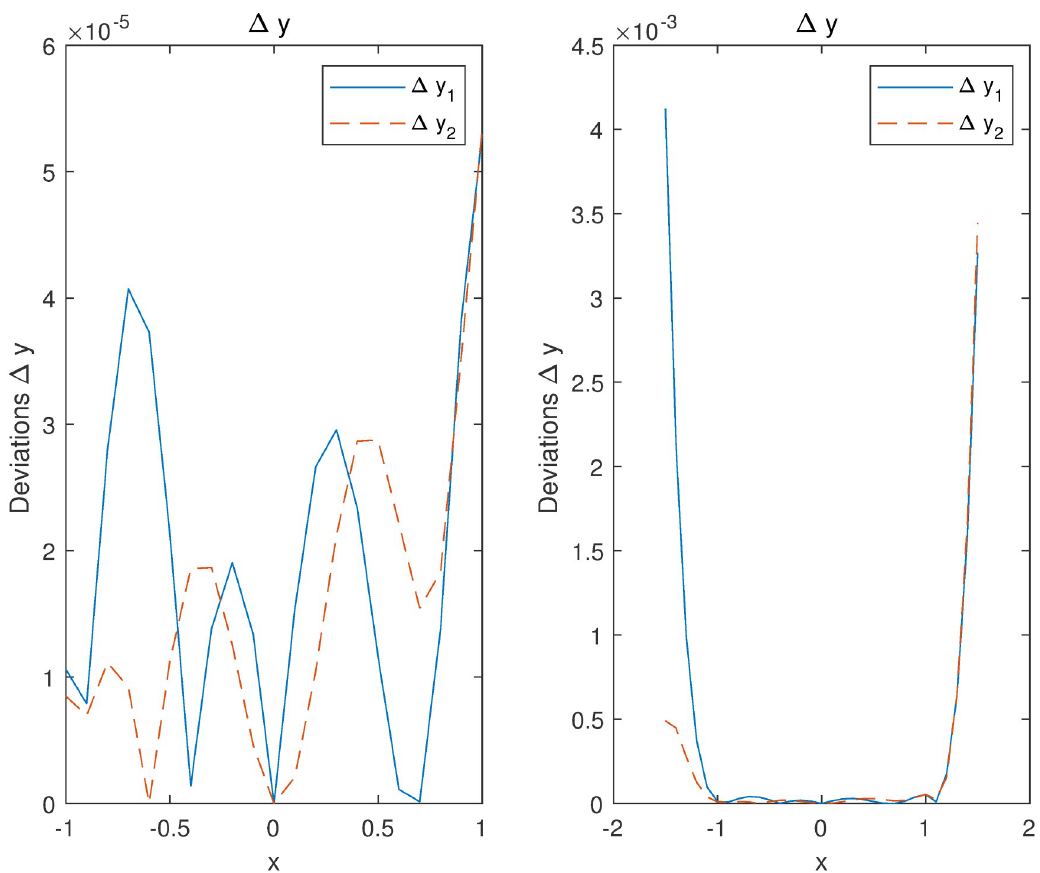
Fig 3. Accuracies of the ^ y